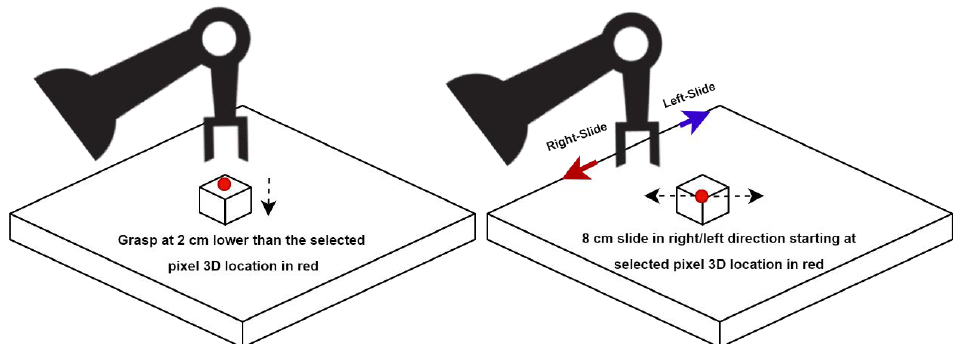
Figure 4. Grasp action ( left ) and left-slide and right-slide actions ( right ).